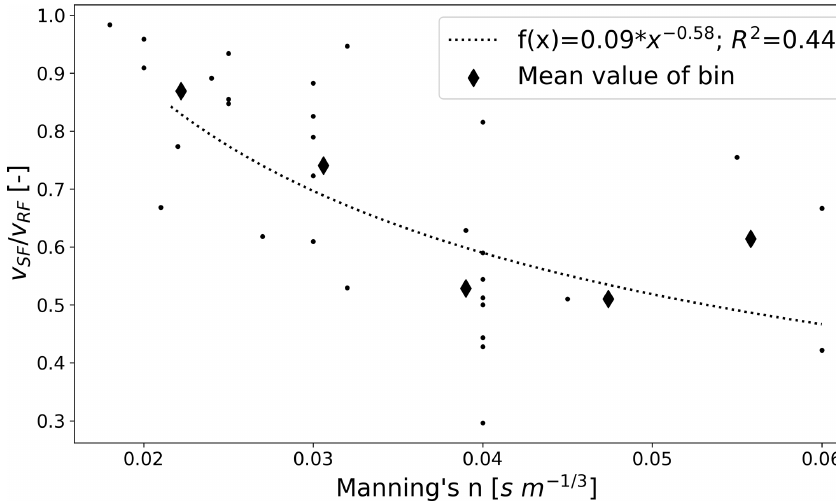
Figure B3. Calibrated flow accumulation C f vs. ratio of sheet to rill flow velocity.